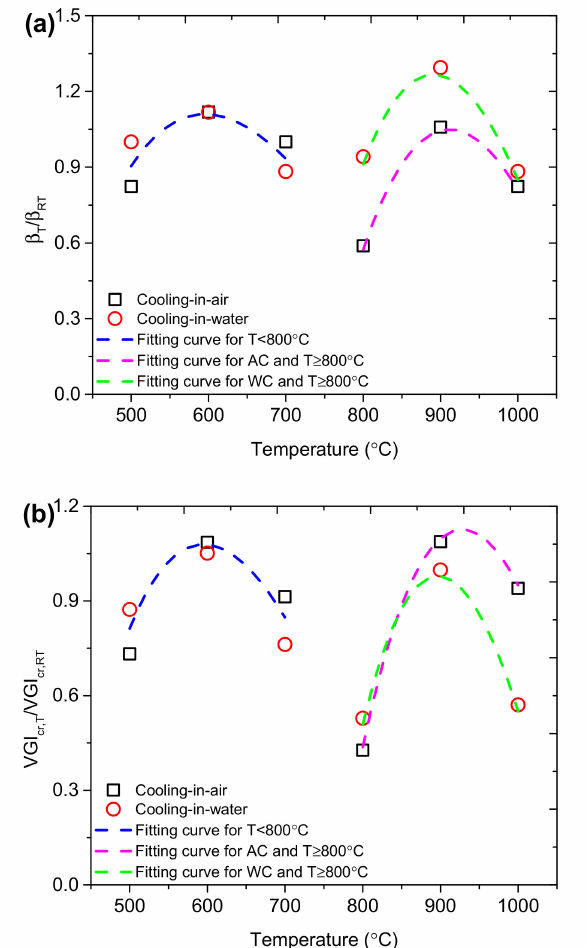
Figure 12. Dependence of VGM fracture parameters on temperature and cooling scenario, ( a ) VGM parameter β , and ( b ) critical fracture index VGI cr